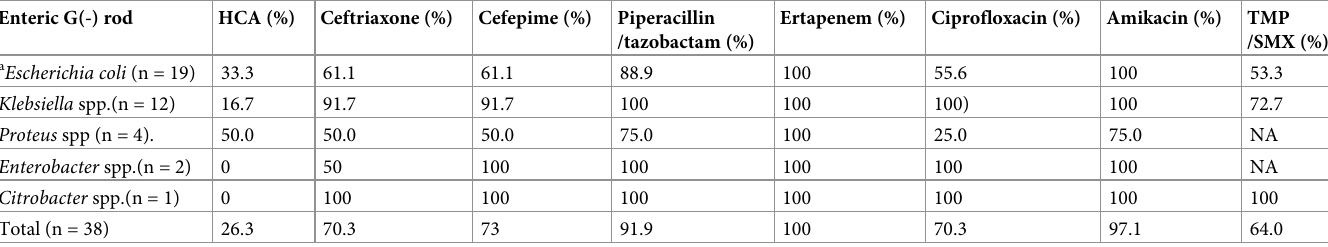
Table 4. Antimicrobial susceptibility of enteric Gram-negative rods isolated from patients with community-onset necrotizing fasciitis. Enteric G(-)